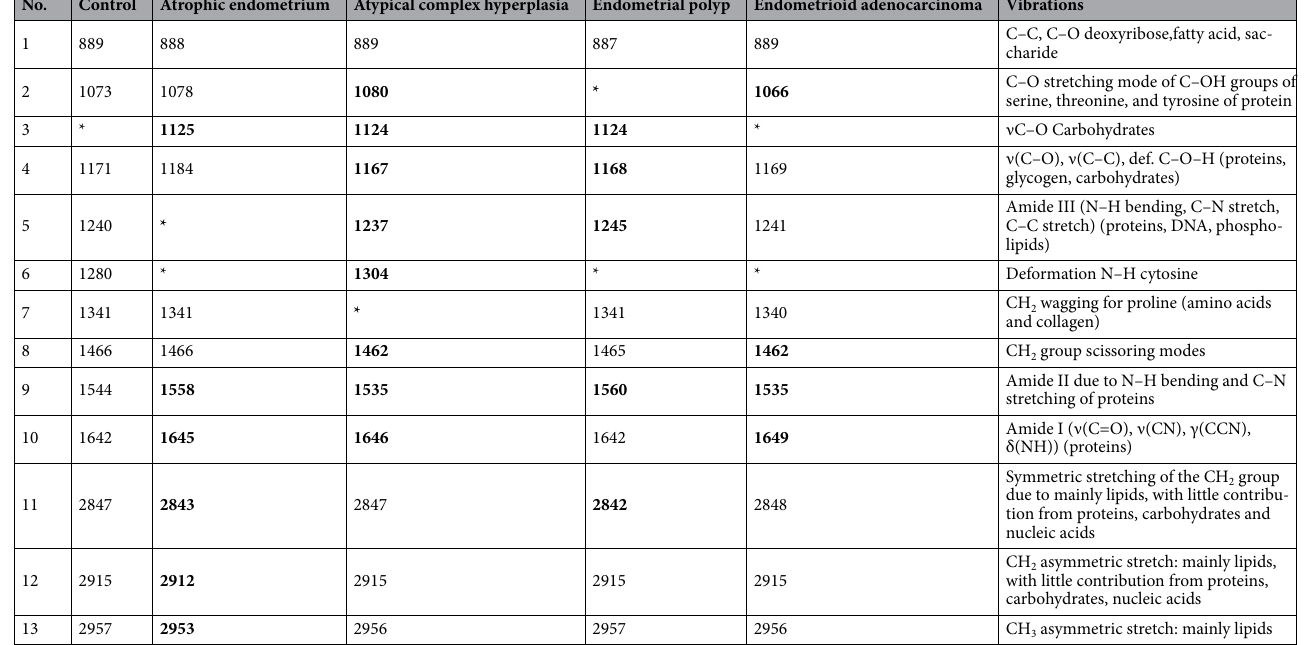
CH 3 asymmetric stretch: mainly